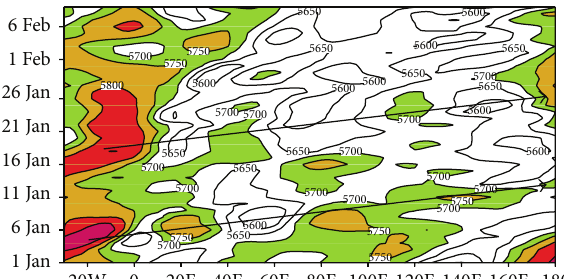
Figure 4: Profile of time and longitude with meridional-averaged geopotential height at 20–40 ∘ N from January 1 to February 10, 2008, at 500 hPa.